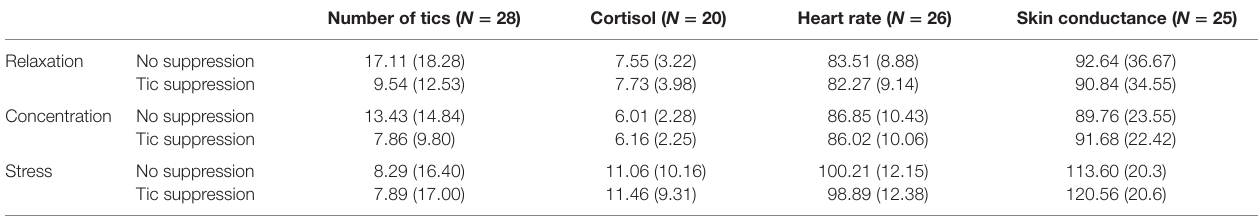
TaBle 1 | number of tics, salivary cortisol level, heart rate, and skin conductance in the n = 6